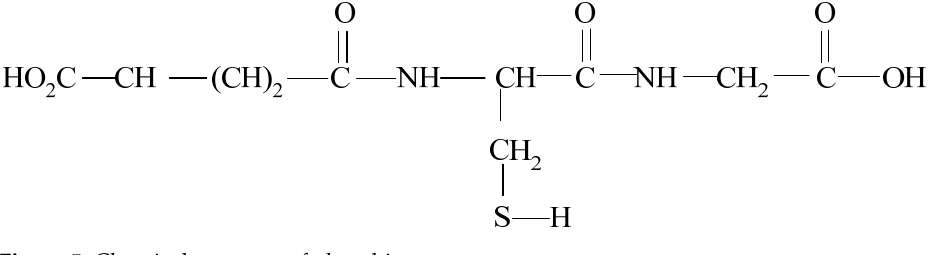
Figure 5. Chemical structure of glutathione.